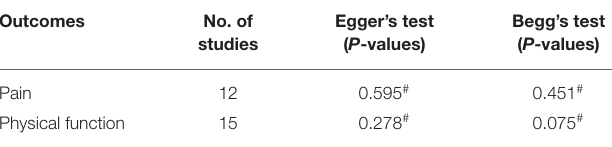
TABLE 4 | Assessment of publication bias.